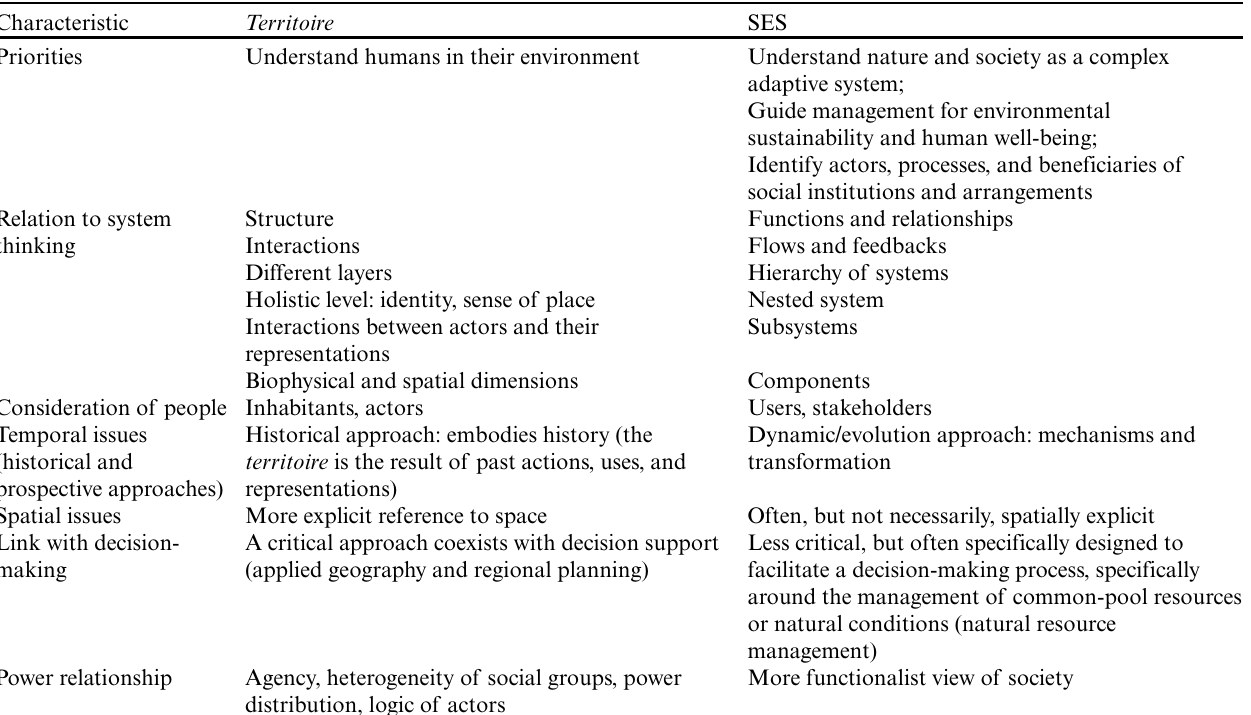
Table 1. Main differences between the two traditions for studying nature-society dynamics: territoire and social-ecological system (SES).